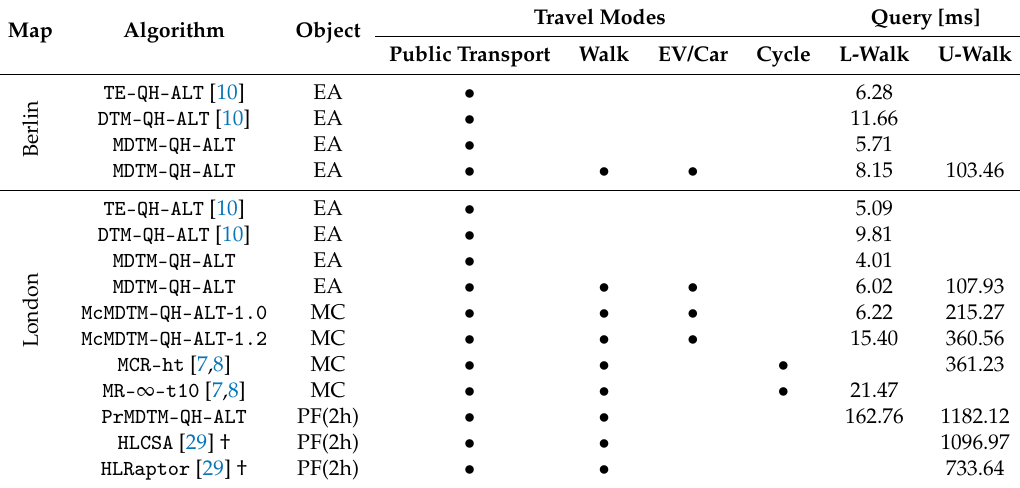
Table 7. Comparison between query algorithms. L-Walk (U-Walk) denotes a query algorithm with limited (unlimited) walking. McMDTM-QH-ALT - 1.0 ( McMDTM-QH-ALT - 1.2 ) denotes McMDTM-QH-ALT